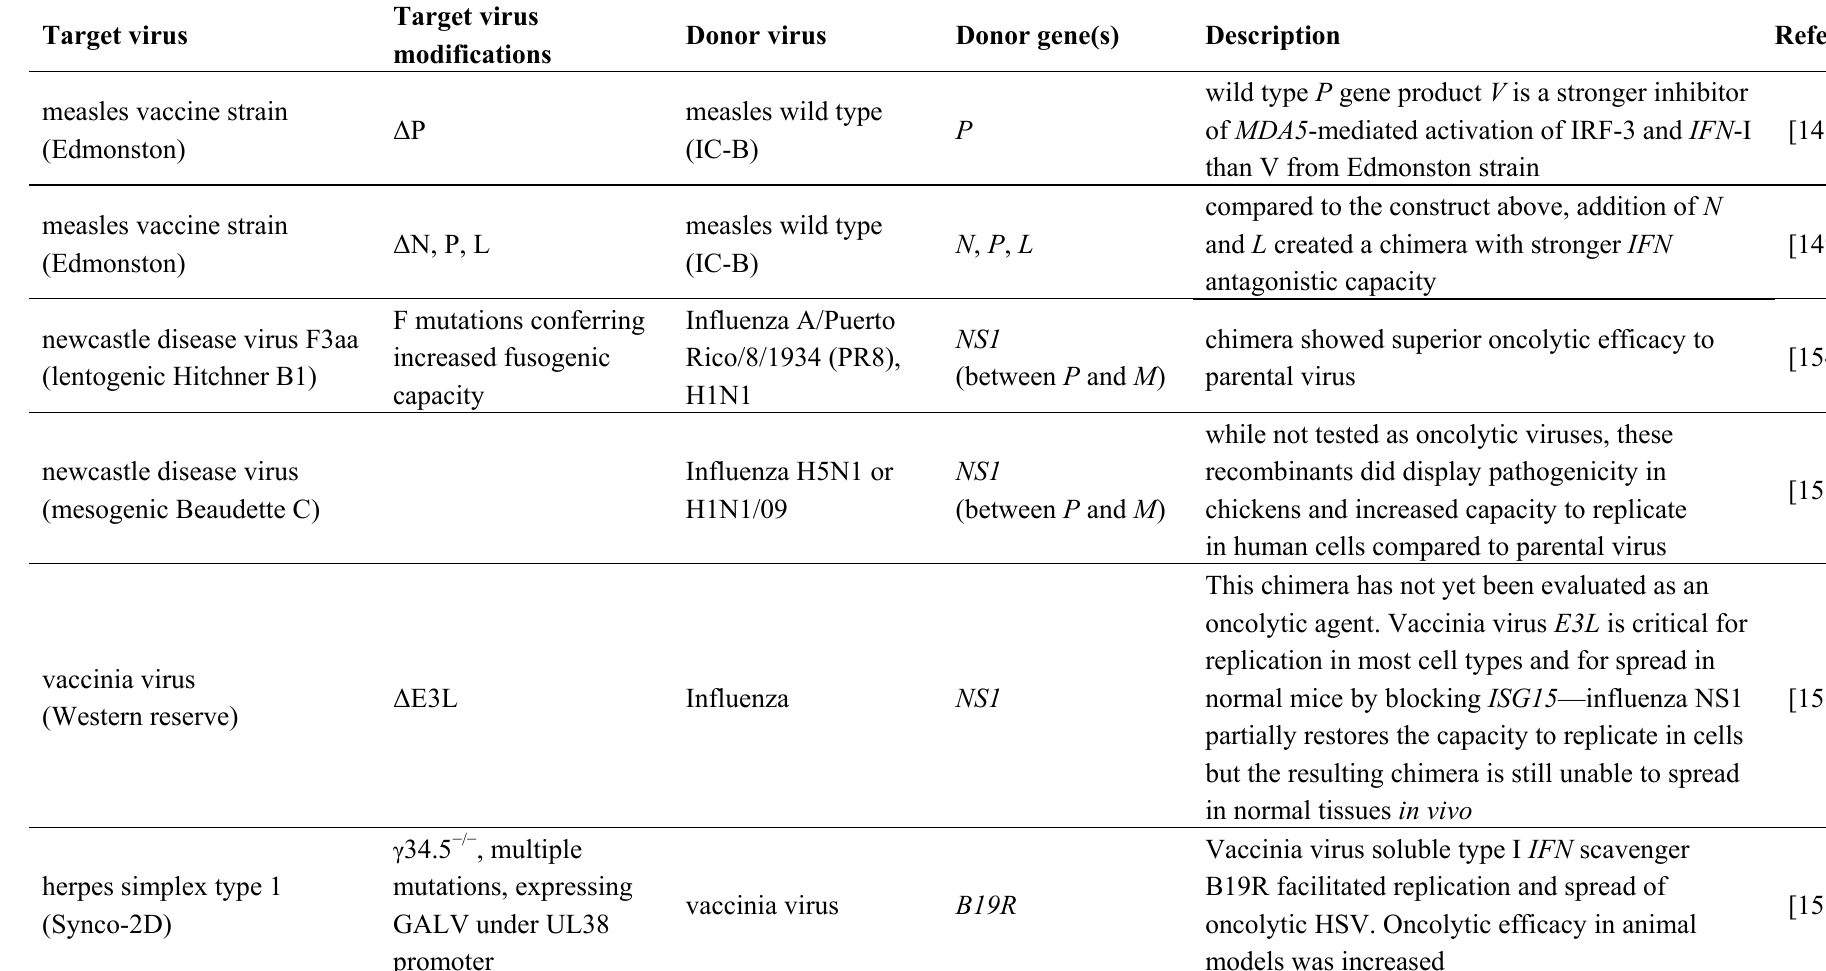
Table 1. Chimeric and recombinant IFN -I-antagonistic viruses. Example chimeric and recombinant viruses with oncolytic potential designed to overcome antiviral defenses. Not all constructs have been tested as oncolytics. Also, note that the nomenclature of vaccinia virus soluble type I IFN scavenger is ambiguous in the literature; “ B18R ” and “ B19R ” are often used interchangeably. Here we use B19R to indicate the type I IFN scavenger, which is the official term for the molecule from the Western Reserve